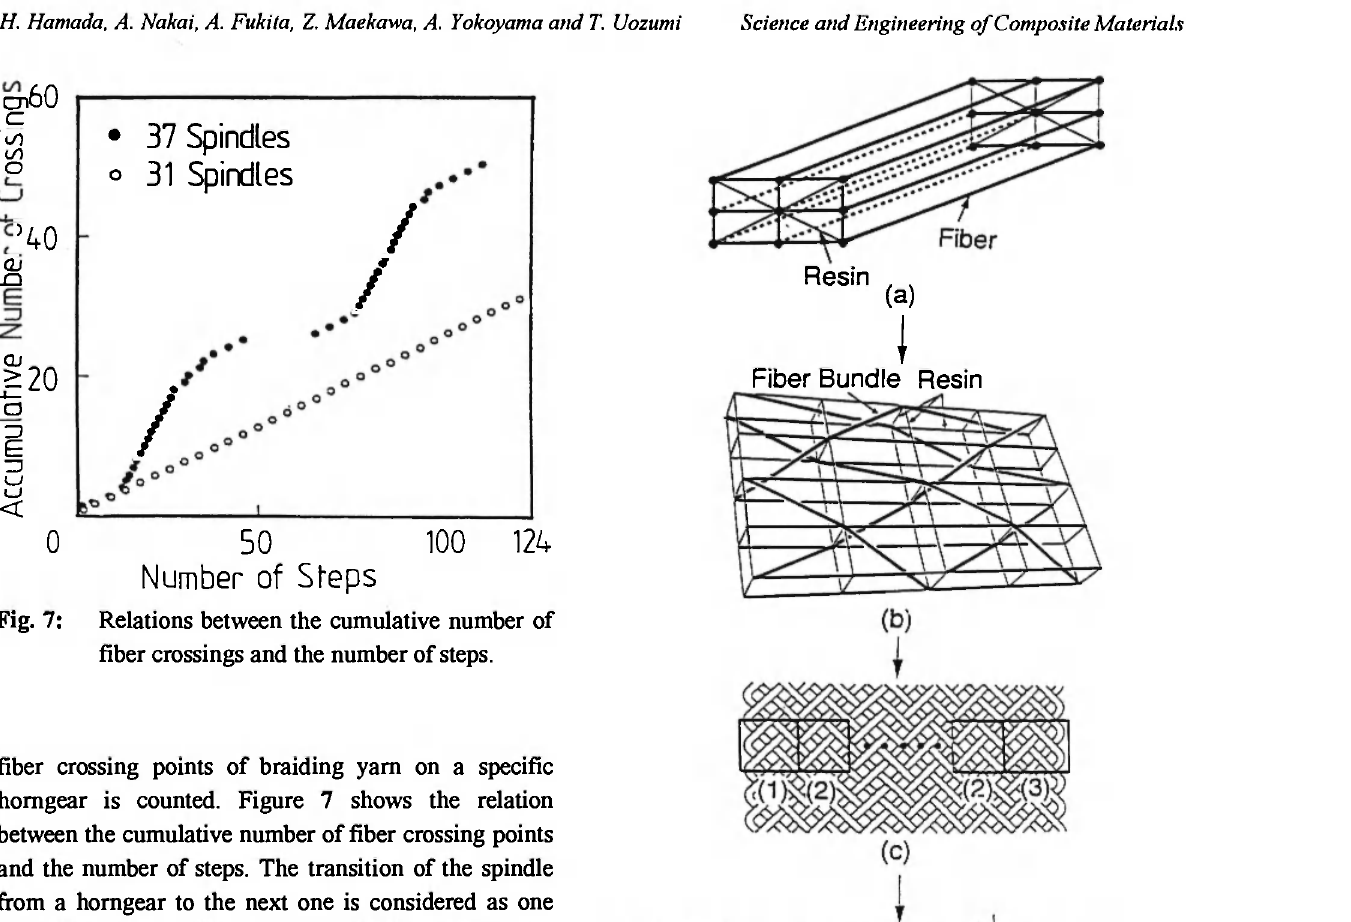
Fig. 8: Analysis procedure and numerical analysis models in each